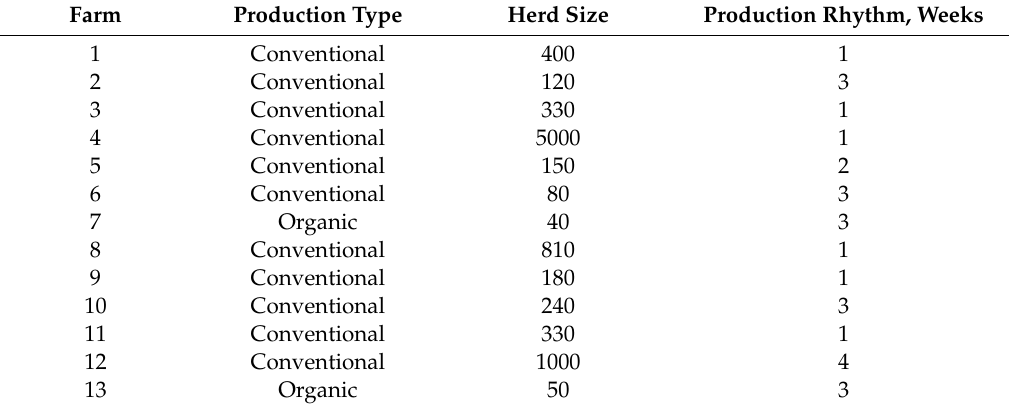
Table 1. Overview of the thirteen farms, which took part in the present study. Presented are: production type, herd size, and production rhythm